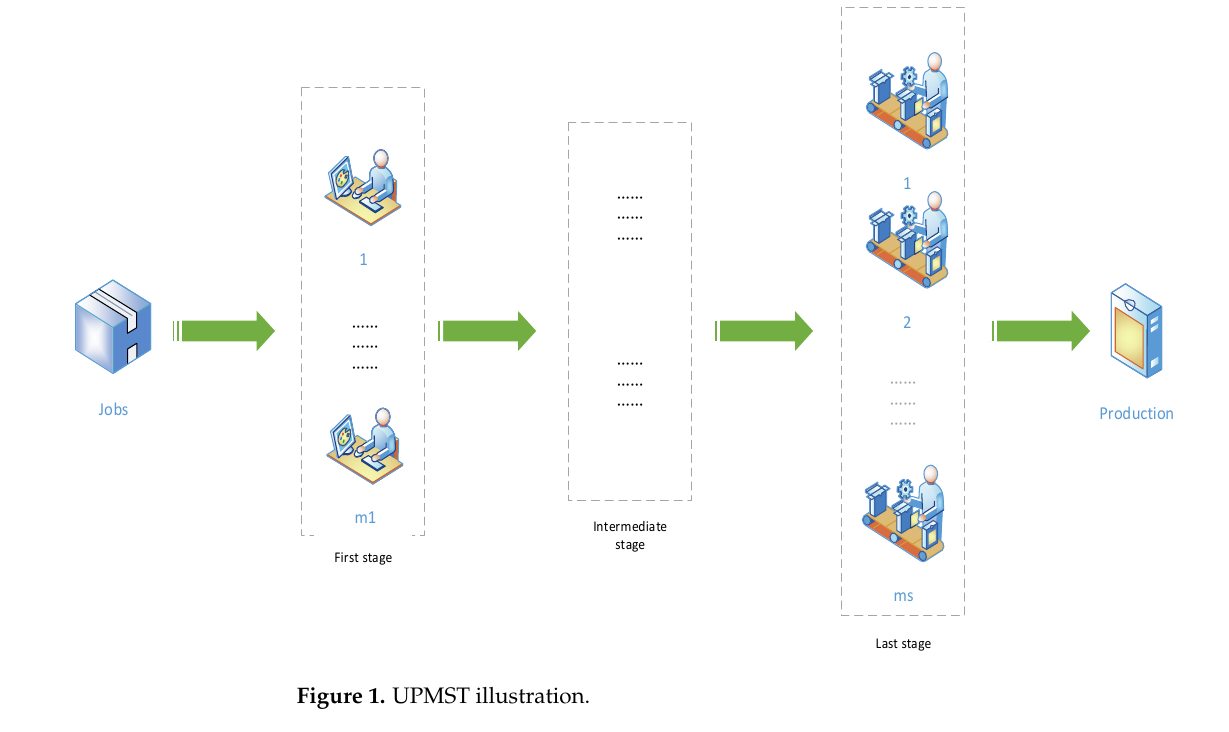
Figure 1. UPMST illustration.